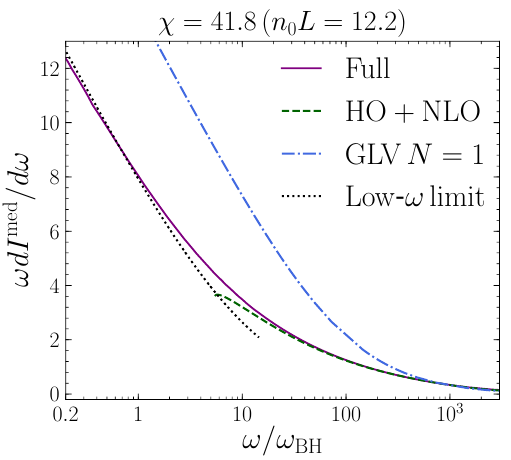
Figure 7 . All-order medium-induced gluon energy spectrum (magenta solid line) compared to the HO+NLO approximation (green dashed), GLV N = 1 result (blue dash-dotted), and the low energy limit of the full resummation described in section 4 (black dotted) as a function of ˆ x = ω/ω BH